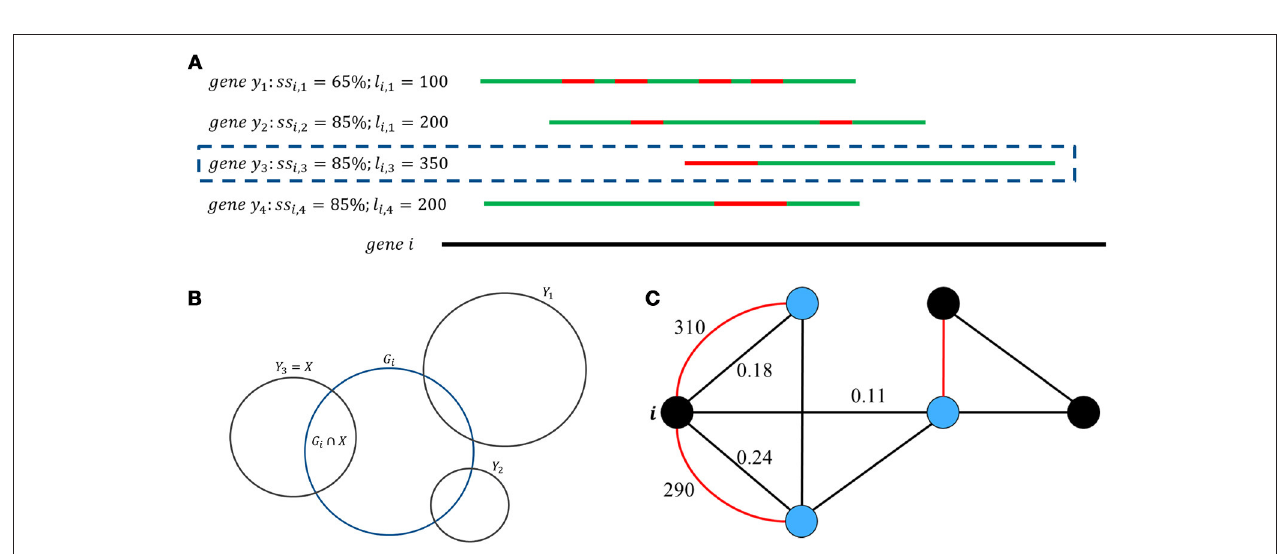
FIGURE 1 | Mapping Uncertainty and GeneQC . (A) The MMR percentages for the 95 datasets across seven species. More detailed information is showcased in Table 1 ; (B) GeneQC takes a read alignment, reference genome, and annotation file as inputs; (C) The first step of GeneQC is to extract features related to mapping uncertainty for each annotated gene; (D) Using the extracted features, elastic-net regularization is used to calculate the D-score, which represents the mapping uncertainty for each gene; (E) A series of Mixture Normal and Mixture Gamma distributions are fit to the D-scores; and (F) The mixture models are used to categorize the D-scores into different levels of mapping uncertainty along with a statistical alternative likelihood value for each gene.